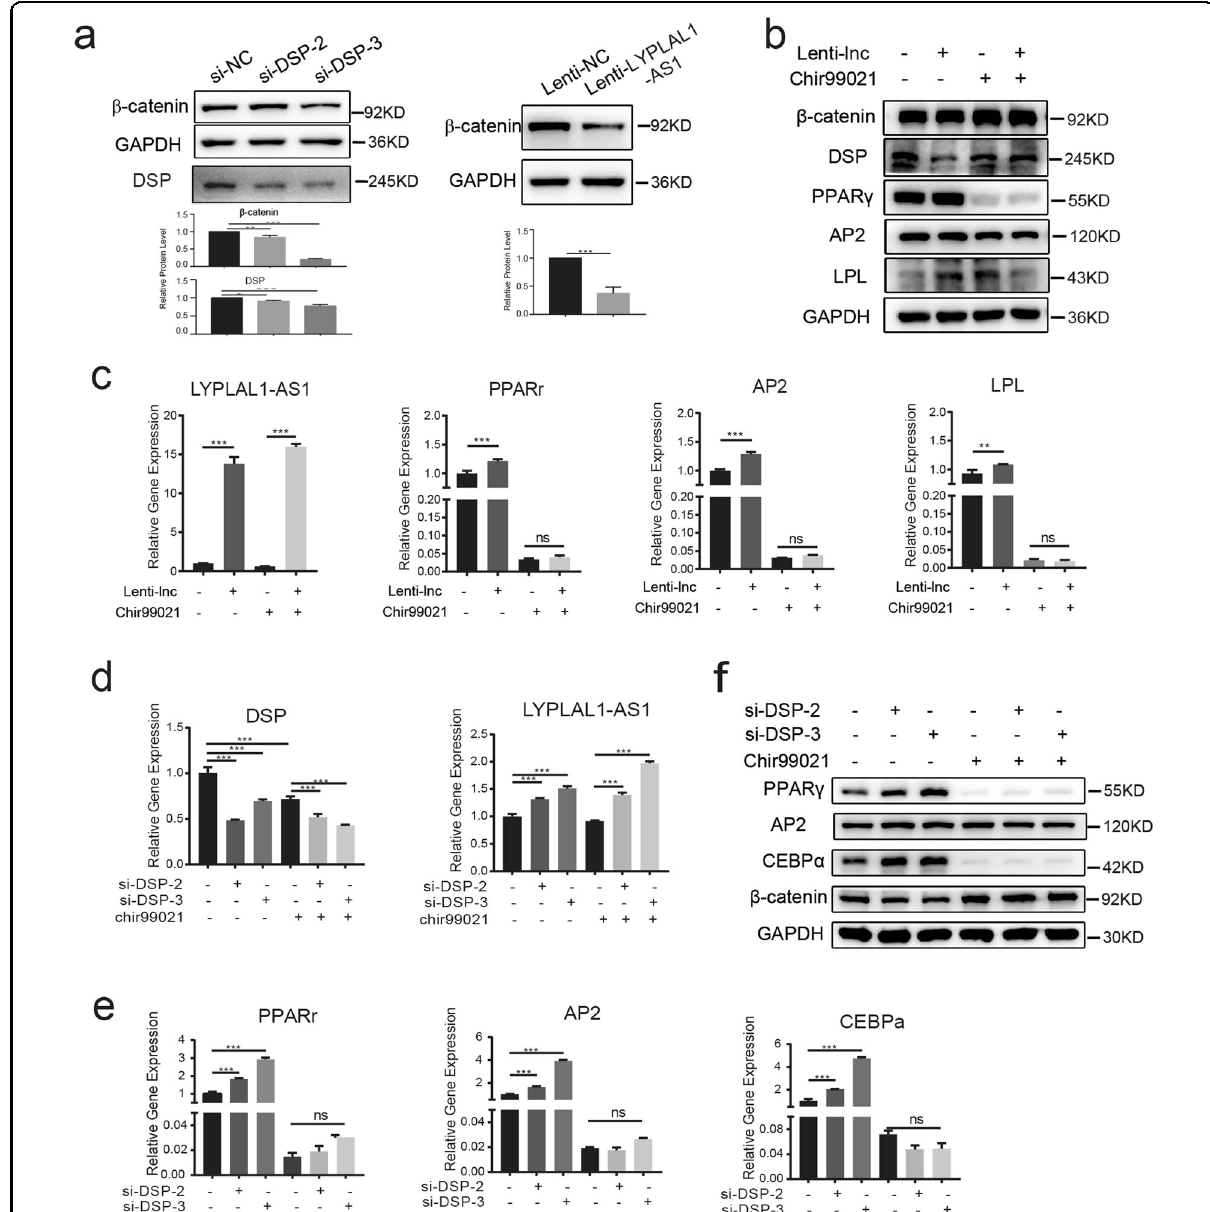
Fig. 7 Wnt/ β -catenin pathway is involved in LYPLAL1-AS1/DSP-regulated adipogenic differentiation of hAMSCs. a Western blot analysis of β -catenin and DSP in DSP knockdown hAMSCs (si-DSP-2, si-DSP-3) and control hAMSCs (si-NC) and western blot analysis of β -catenin in hAMSCs that overexpress LYPLAL1-AS1 (Lenti-LYPLAL1-AS1) and control hAMSCs (Lenti-NC). b Western blot analysis of β -catenin, DSP, and adipogenic markers (PPAR γ , AP2, and LPL) in hAMSCs that overexpress LYPLAL1-AS1 (Lenti-LYPLAL1-AS1; Lenti-lnc + ) and control hAMSCs (Lenti-NC; Lenti-lnc − ) after treatment without or with chir99021. c qRT-PCR analysis of LYPLAL1-AS1 and adipogenic markers (PPAR γ , AP2, and LPL) in hAMSCs that overexpress LYPLAL1-AS1 and control hAMSCs after treatment without or with chir99021. d qRT-PCR analysis of LYPLAL1-AS1 and DSP in DSP knockdown (si-DSP- 2, si-DSP-3) and control hAMSCs after treatment without or with chir99021. e qRT-PCR analysis of adipogenic markers (PPAR γ , AP2, and CEBP α ) in DSP knockdown and control hAMSCs after treatment without or with chir99021. f Western blot analysis of β -catenin and adipogenic markers (PPAR γ , AP2, and CEBP α ) in DSP knockdown and control hAMSCs after treatment without or with chir99021.GAPDH was used as the internal control for the western blot assays. The quantitative data were normalized to GAPDH, n = 3; data are shown as the mean ± SD; * P < 0.05, ** P < 0.01, *** P < 0.001; n.s., not signi fi